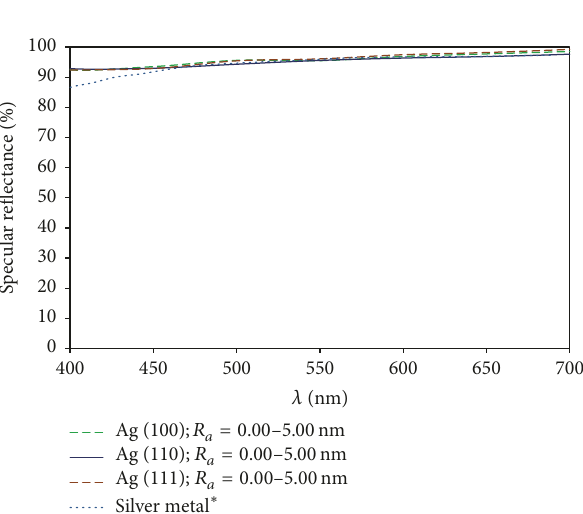
Figure 2: Specular reflectance (SR) versus wavelength spectrum of Ag (100), (110), (111) crystals with 𝑅 𝑎 = 0.00–5.00 nm and silver metal. ∗ The reflectance of silver metal was obtained from the literature values of silver optical constants published by Palik